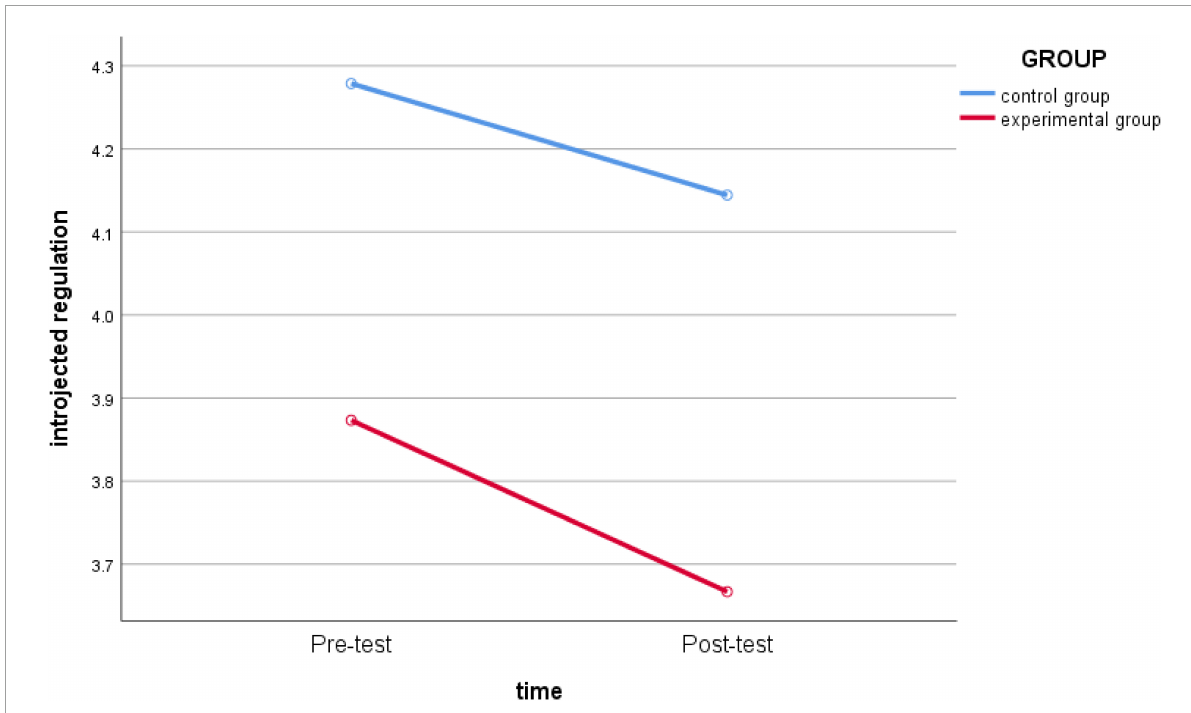
FIGURE4 Schematic diagram of the changes in introjected regulation between the experimental group and the control group before and after intervention.